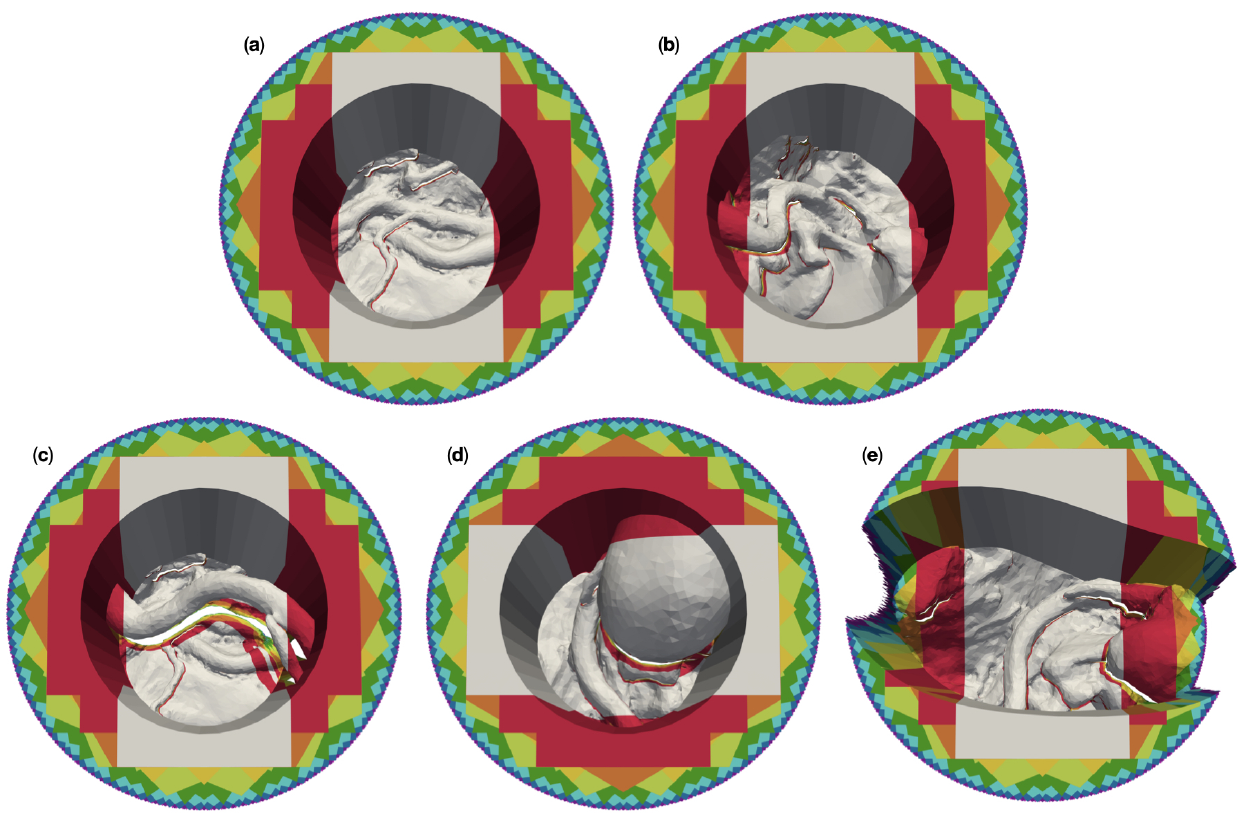
Figure 8. Overlay plots of the 3D reconstructable surfaces of the five different 50mm-channel surgical site models for different camera numbers. The reconstruction with the largest area was placed in the background and the reconstruction with the smallest area in the foreground. The areas are color coded by number of cameras: Gray for two cameras, red for four cameras, orange for six, yellow for eight, lime for 16, green for 32, cyan for 64, blue for 128, purple for 256, and magenta for 360. ( a ) shows the reconstruction of “circ flat anatomy”. ( b ) does this for “circ angled anatomy”, ( c ) for “circ artery”, ( d ) for “circ overhang”, and ( e ) for the “elliptical channel”